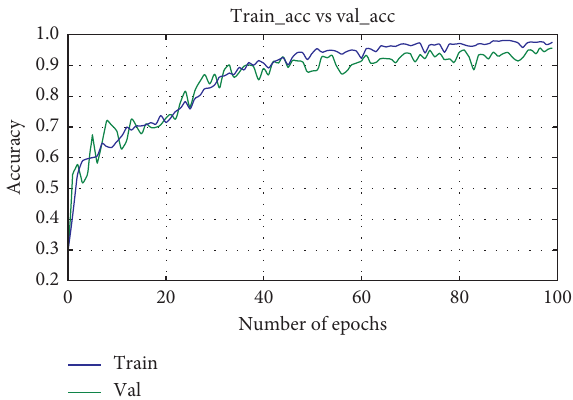
Figure 9: Training accuracy and validation accuracy of the model.